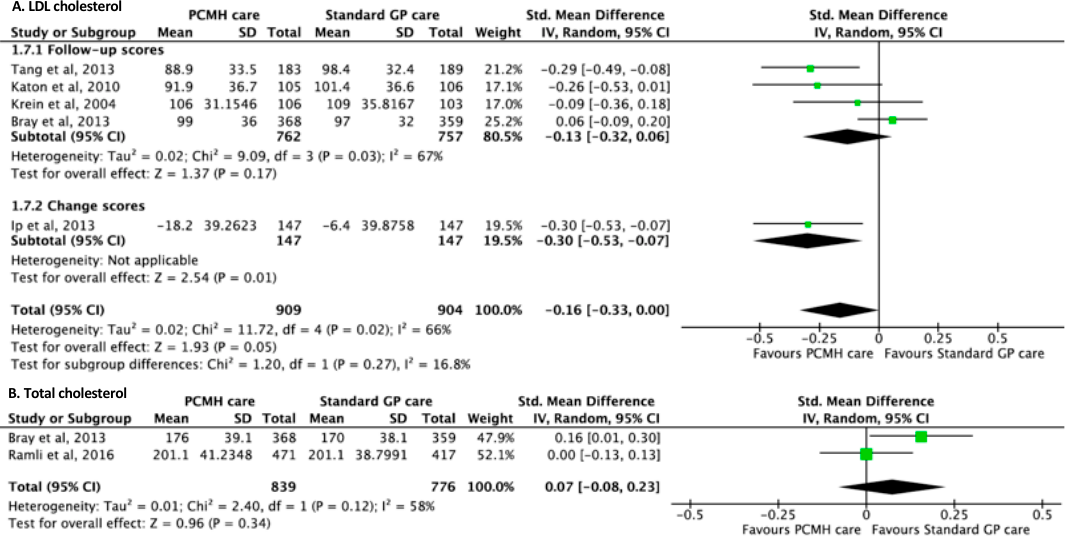
Figure 7. Forest plots of ( A ) LDLcholesterol and ( B ) Total cholesterol outcomes between the PCMH care and Standard GP care.